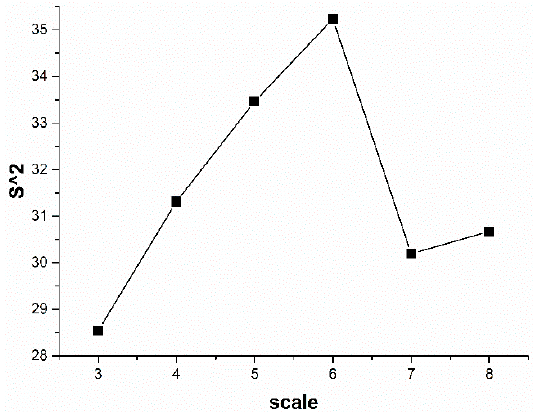
Figure 7. Weighted mean variances of segments for different scale factors (3,4,5,6,7,8).